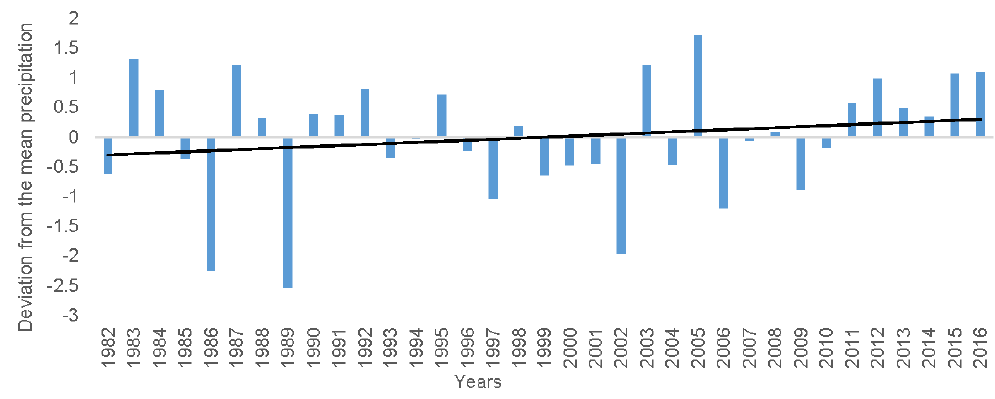
Figure 4. Annual precipitation anomalies for Dwangwa-Nkhotakota weather station from 1982 to 2016.